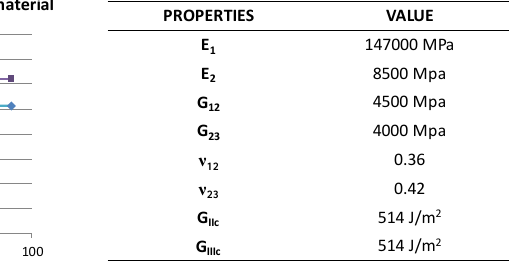
Figure 2. Resistance curves and mechanical material properties.